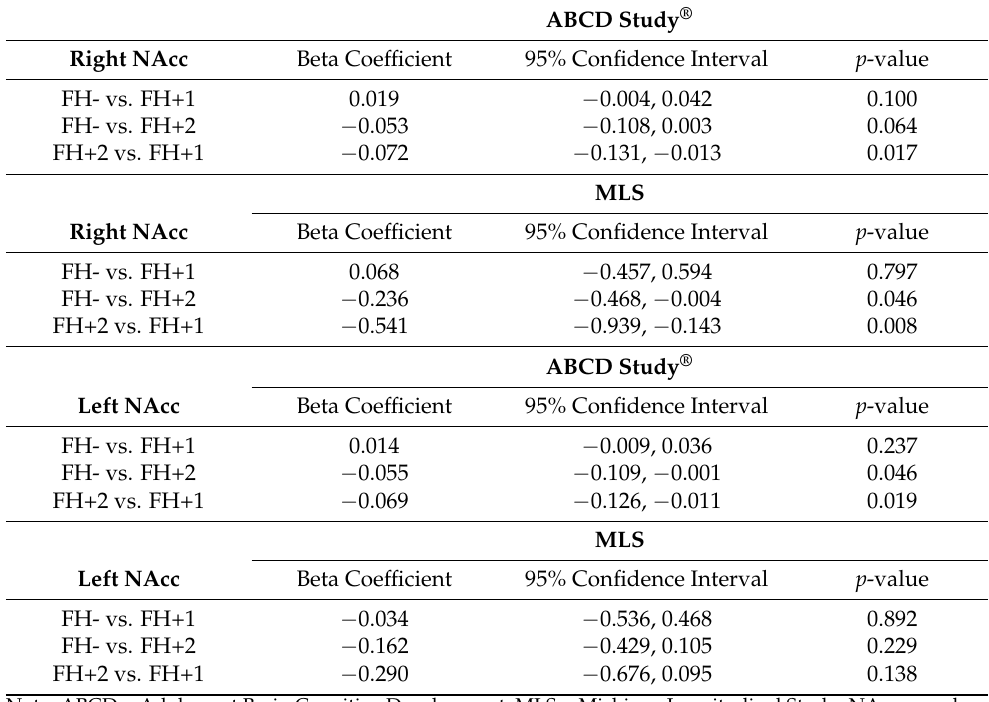
Table 1. Regression model results by ABCD Study ® and MLS family history